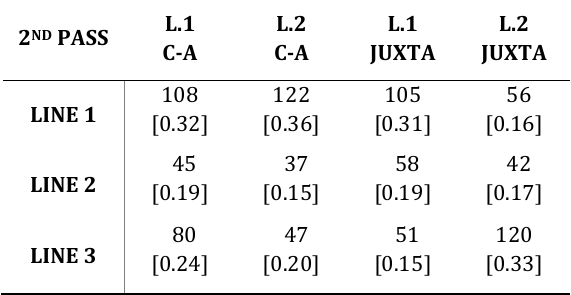
Table 3B. Second-pass dwell times (per word) following regressive saccades, Fisher Least Square Difference=44 ms [likelihood of re-fixations, Difference=0.10].